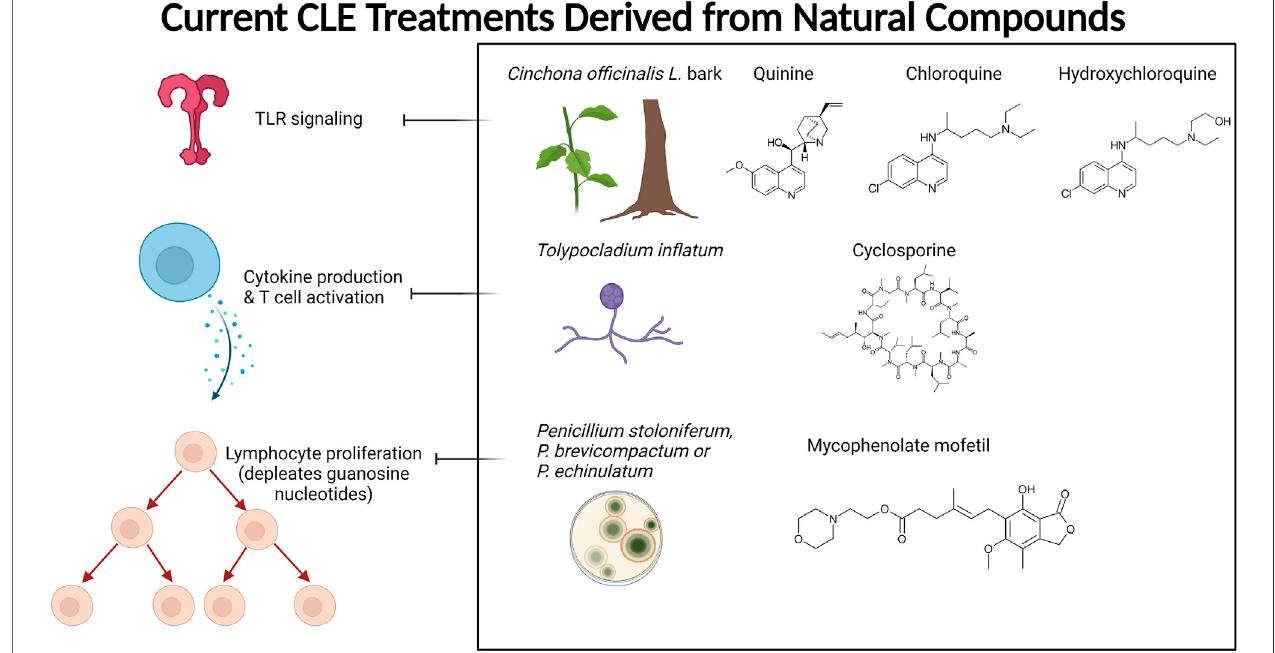
FIGURE 1 | Current CLE treatments derived from natural compounds. Antimalarials are originally derived from the bark of the Cinchona tree. The active ingredient quinine is a TLR inhibitor that provides relief and maintenance therapy for CLE patients. Cyclosporine A (CsA) is also used to treat CLE, which is derived from the fermentation ofthefungus Tolypocladiumin fl atum andrelated species.CsApreventscytokineproduction(mainlyIL-2)andsubsequentTcellactivation. Mycophenolate mofetil (CellCept) is also fungal-derived from Penicillium species, and its mechanism of action is to deplete guanosine nucleotides preferentially in T and B lymphocytes, which ultimately prevents proliferation, antibody formation, and cell-mediated immunity. Created with BioRender.com.